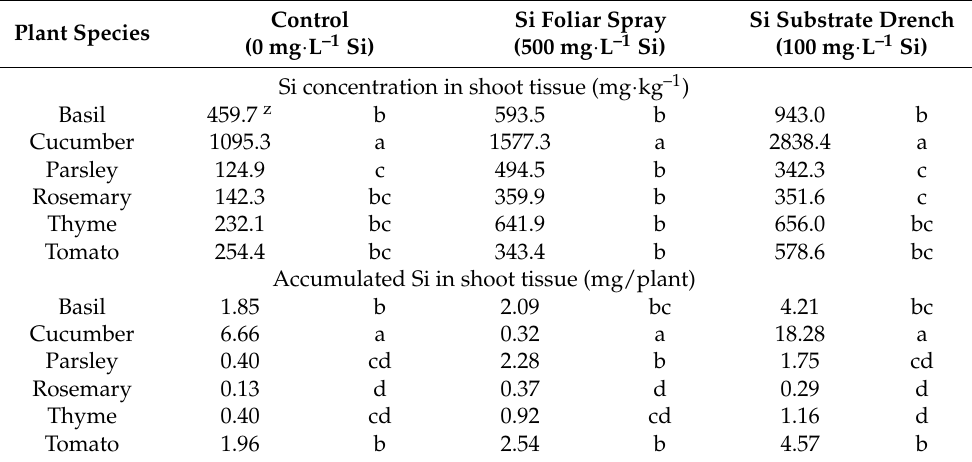
Table 4. Supplemental silicon (Si) treatment effects on Si concentration and total accumulated Si in dried shoot tissues at the end of production for six container-grown edible species. Silicon foliar spray and substrate drench treatments were applied every 7 days during production. Plant